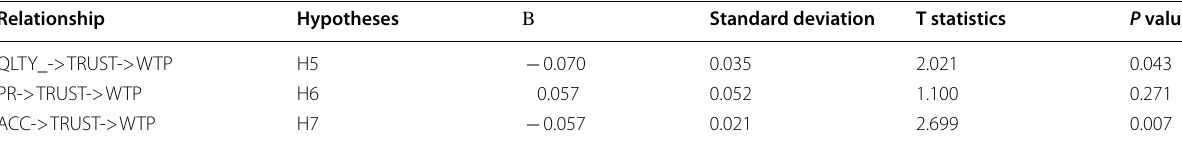
Table 5 Specific indirect effects